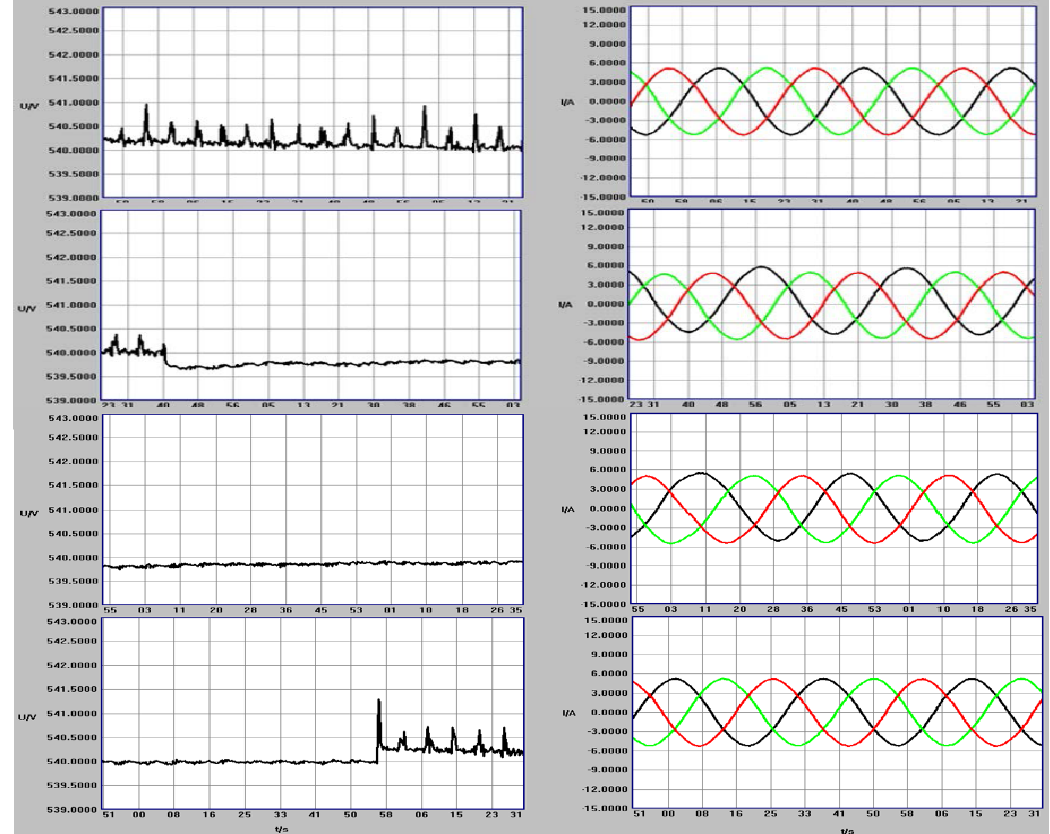
Figure 10. Waveforms of DC bus interface voltage and current on the grid side.